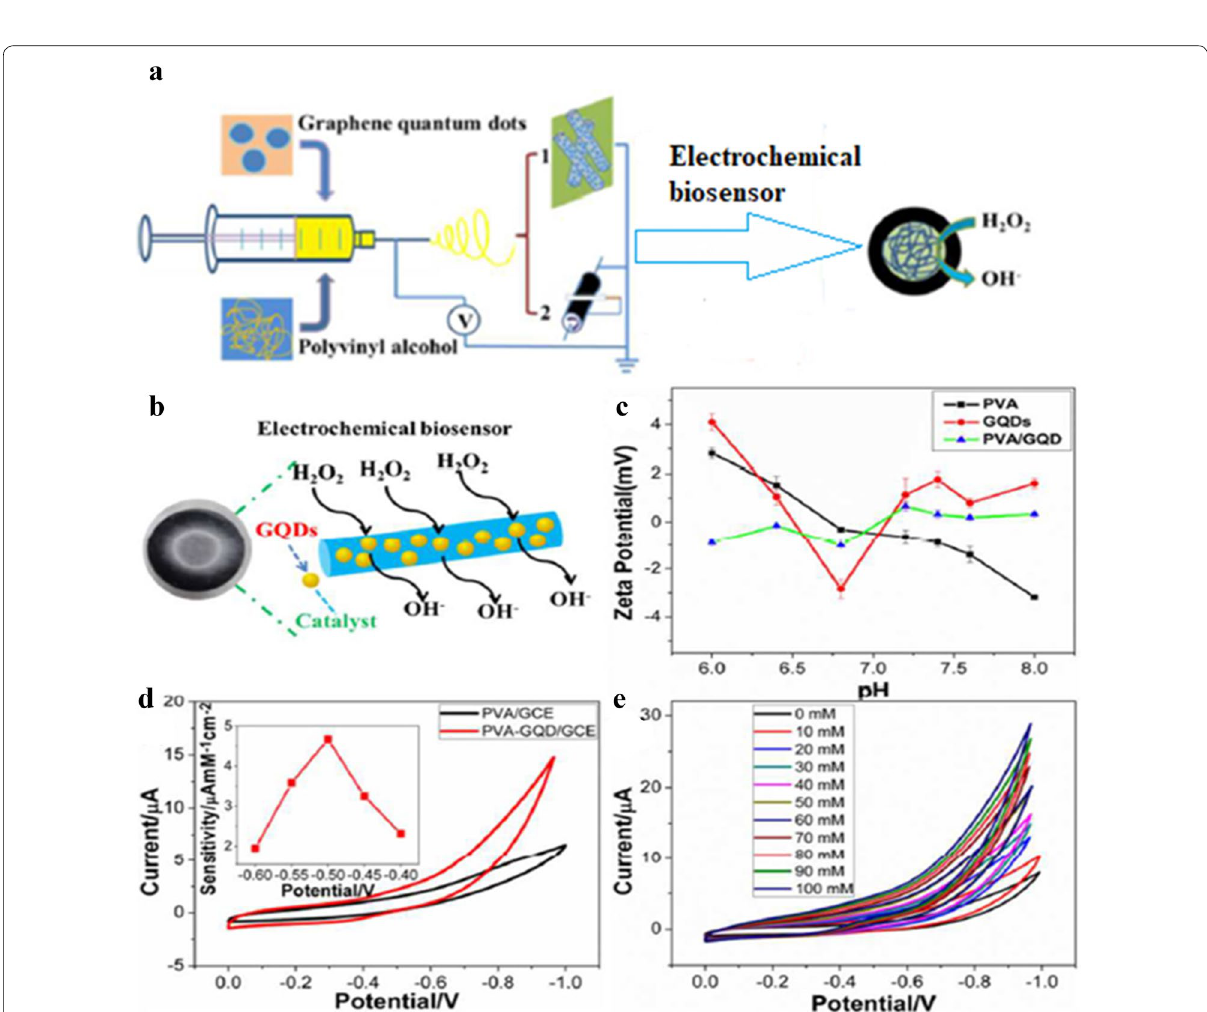
Fig. 5 a Schematic presentation of electrospinning for producing PVA/GQD onto GCE for electrochemical biosensing and catalyzing of H 2 O 2 , b the possible detection mechanism, c Zeta potentials of GQDs, PVA, and PVA/GQD nanofibrous membranes at varied pH, d CVs of GCEs modified with PVA and PVA/GQD nanofibrous membranes, sensitivity of the biosensor at different potentials (inset), e CVs of the PVA/GQD nanofibrous membranes modified GCE 0.1 M PBS with different addition of H 2 O 2 (Reproduced with permission from [202], Copywrite 2015 Royal Society of